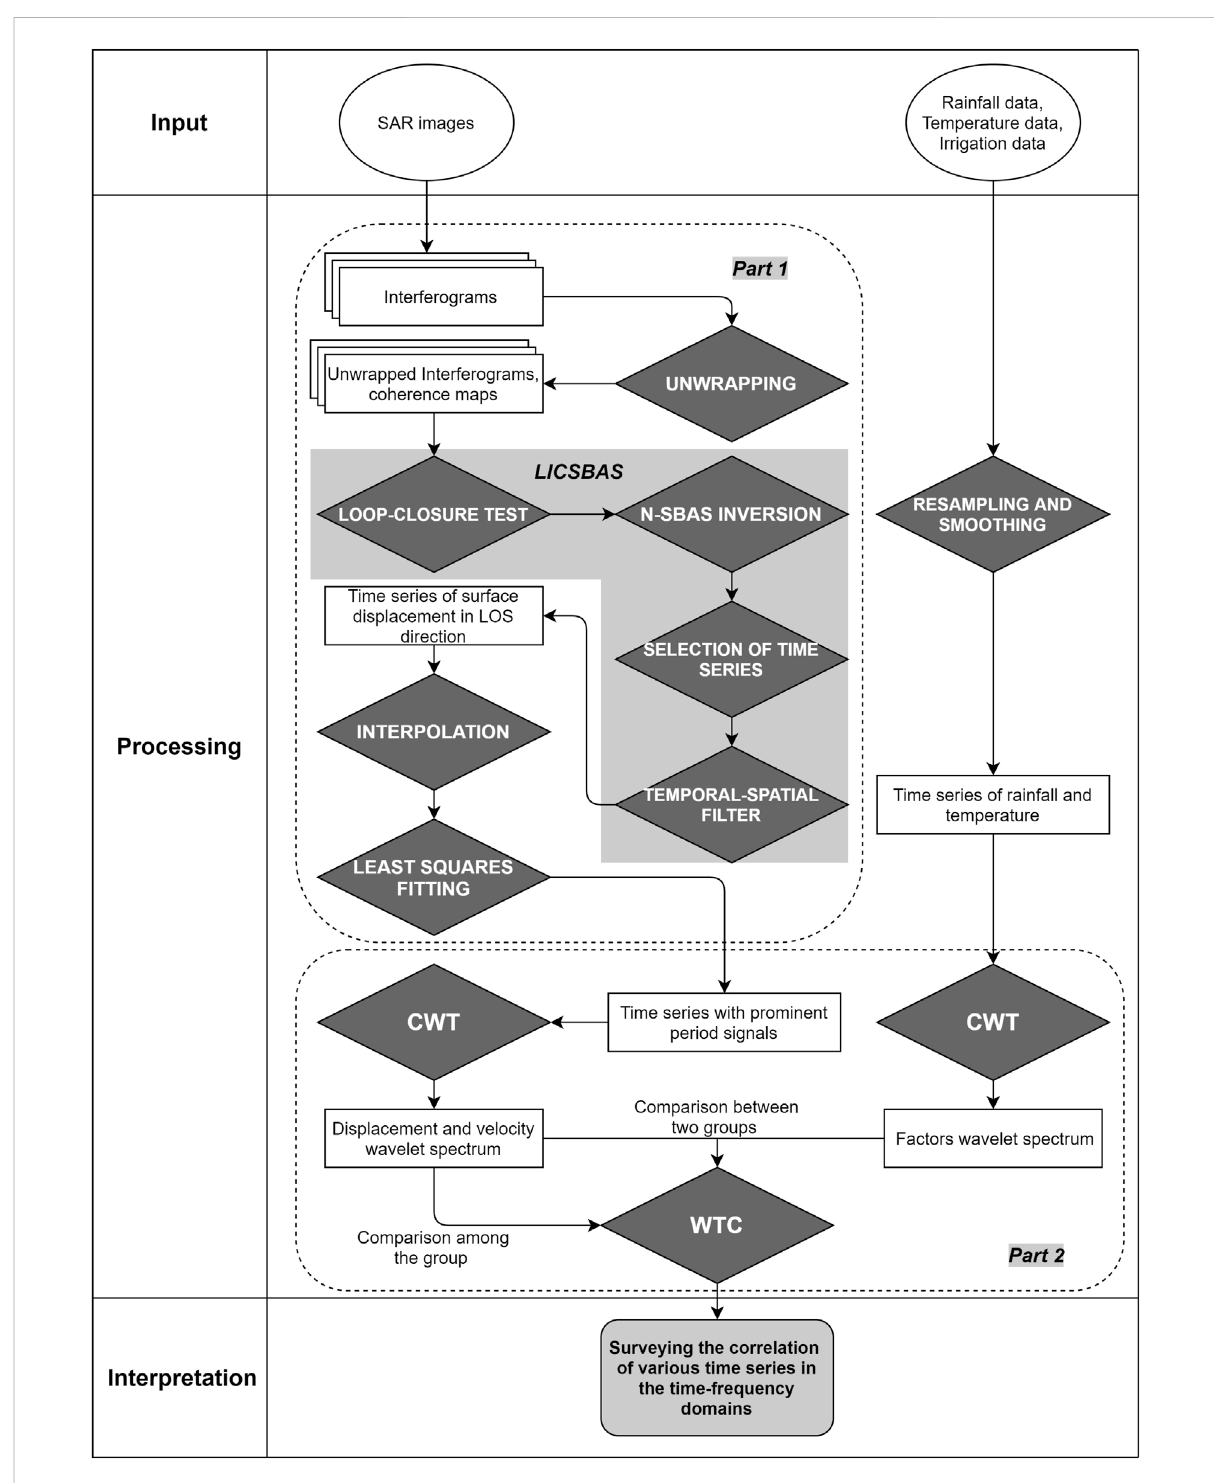
Flowchartofdataprocessing,includingtime-seriesInSARandwaveletanalysis.Twogroupsofdata,timeseriesofsurfacedisplacementderived fromtheInSARandhydrologicaldatasetsuchasprecipitationandtemperature,areanalyzedjointly.Theblockingrayistheprocessingimplemented by the open-source LiCSBAS (Morishita et al.,